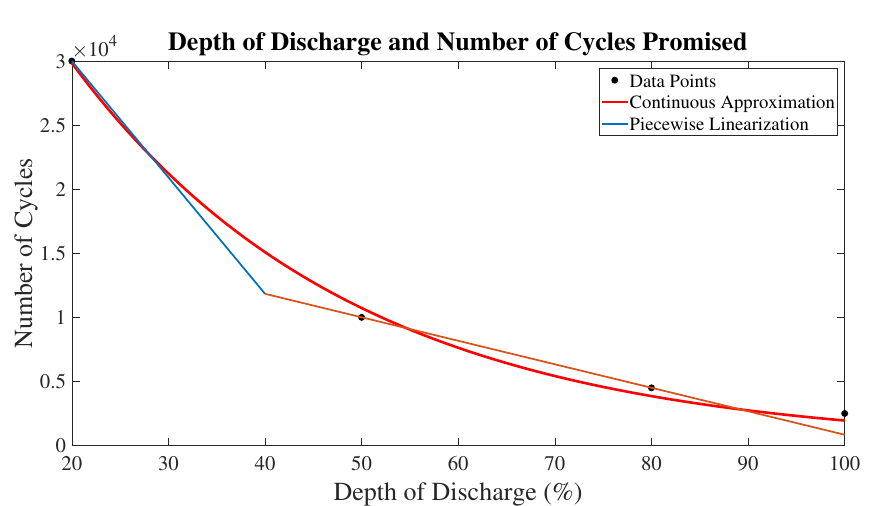
Figure 2. Relationship between number of cycles with depth of